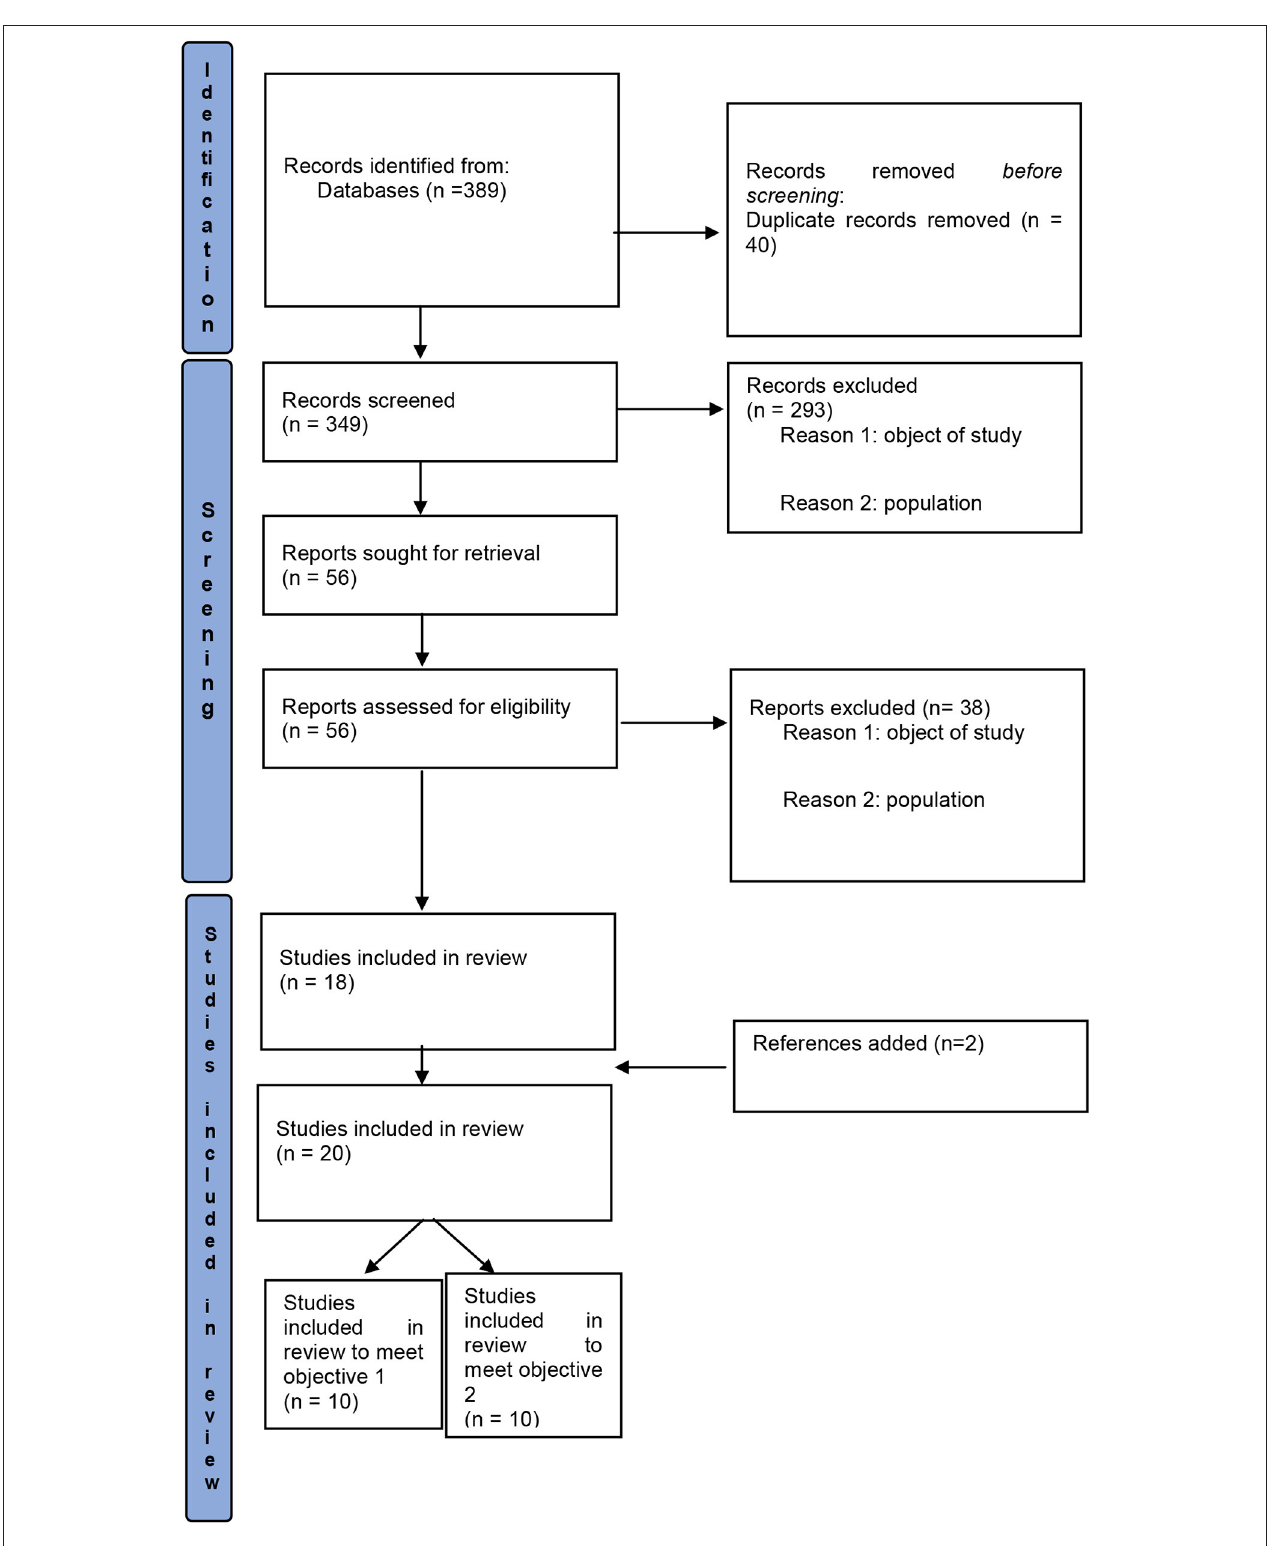
FIGURE 1 | Flowchart of the study selection